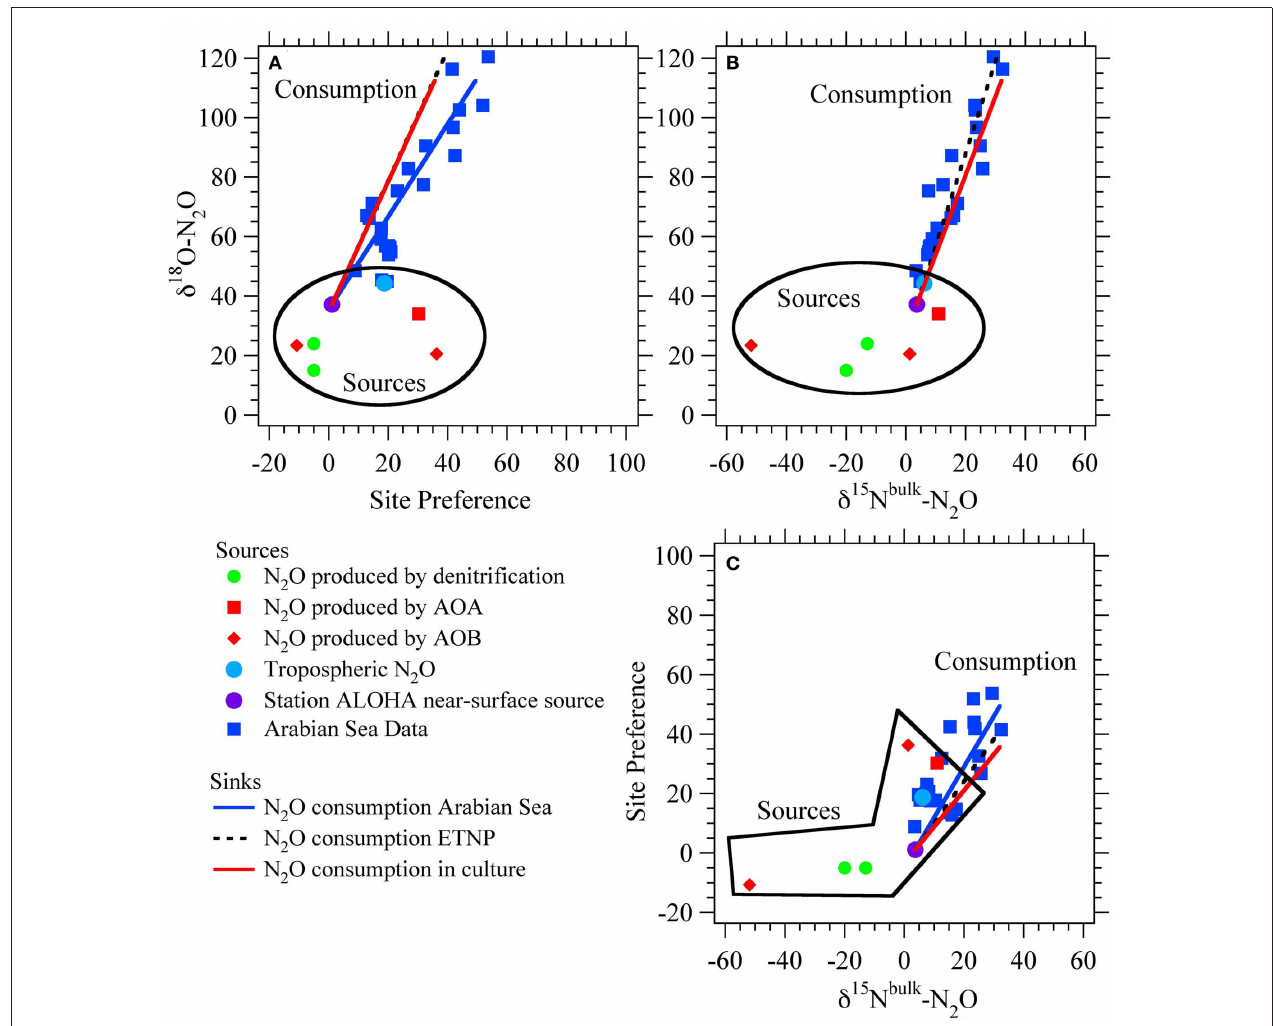
FIGURE 2 | Isotopic signatures for nitrous oxide sources and sinks. Isotope-isotope plots for N 2 O sources from ammonia-oxidizing archaea (AOA; Santoro et al., 2011), nitrification and nitrifier-denitrification by ammonia-oxidizing bacteria (AOB; Frame and Casciotti, 2010), and production by denitrification of NO − 3 or NO − 2 (Barford et al., 1999; Casciotti et al., 2007). Also shown are average tropospheric air (Kim and Craig, 1990; Yoshida and Toyoda, 2000; Croteau et al., 2010) and the